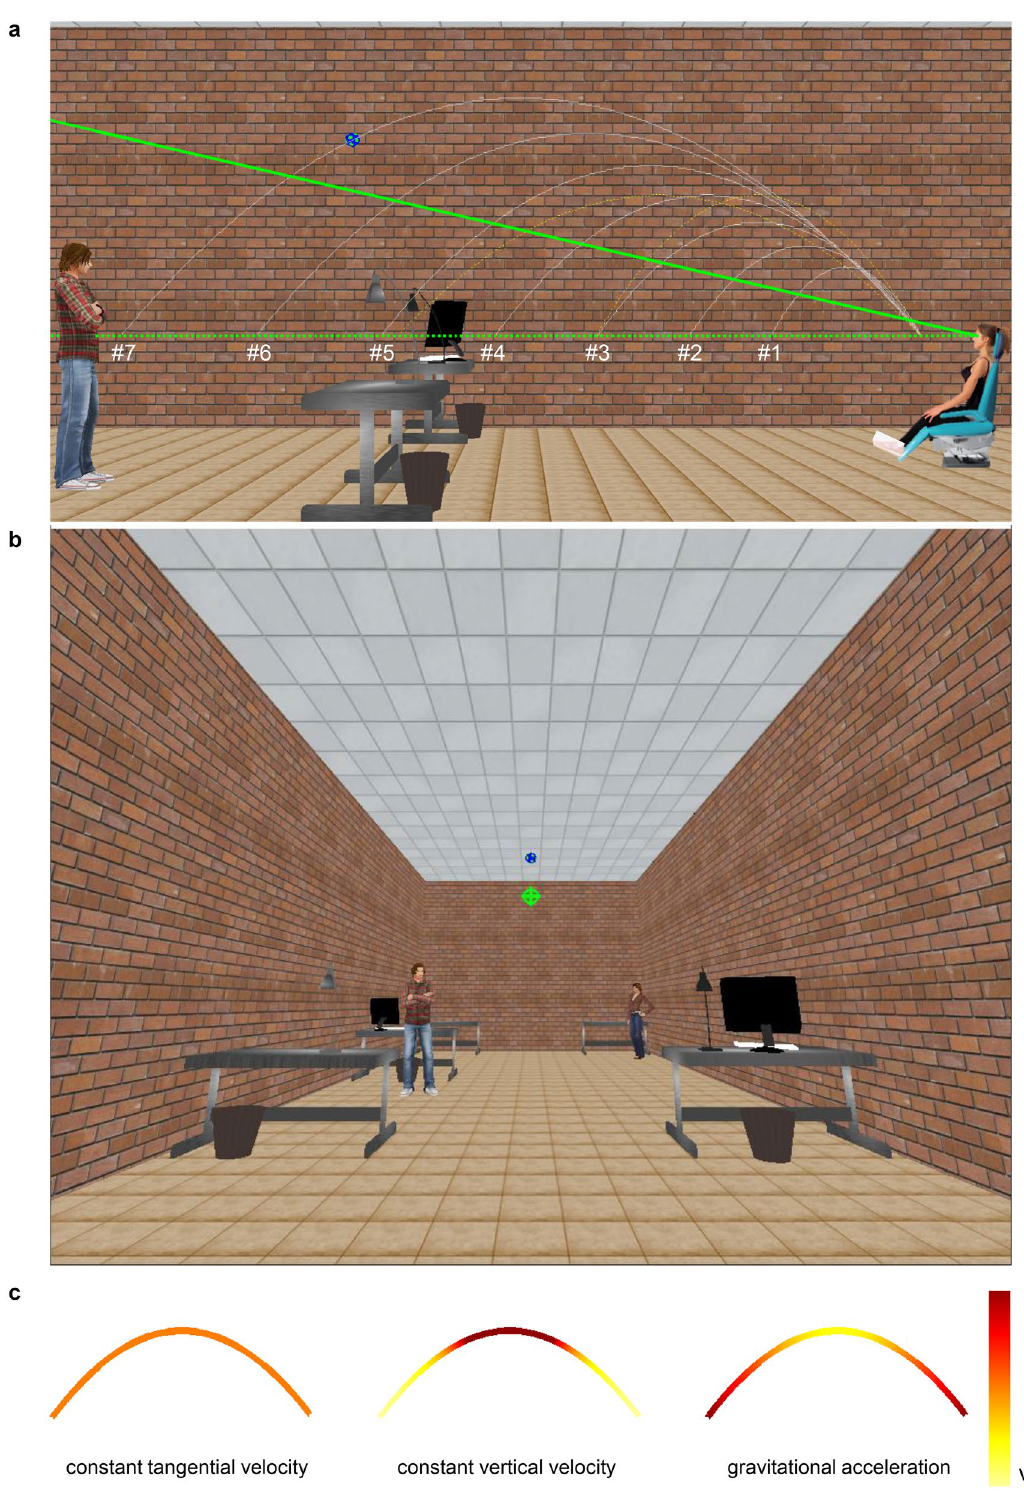
Figure 1. Schematic of the experimental setup and visual stimuli. Panel ( a ) The seated woman and the blue chair indicate the position of the participant. White lines represent the parabolic paths of the target (textured blue ball) for conditions #1-#7. Yellow dot lines represent the parabolic paths for the control conditions #8 and #9. Starting position and final position of the ball are aligned with participant’s eyes (green horizontal dotted line). Solid green line is the gaze line during fixation. Panel ( b ) Visual stimulus as seen by the participant. The fixation cross is green. Panel ( c ) Exemplary profiles of color-coded changes of the tangential velocity for the three laws of motion. Velocity increases from yellow to red in the color